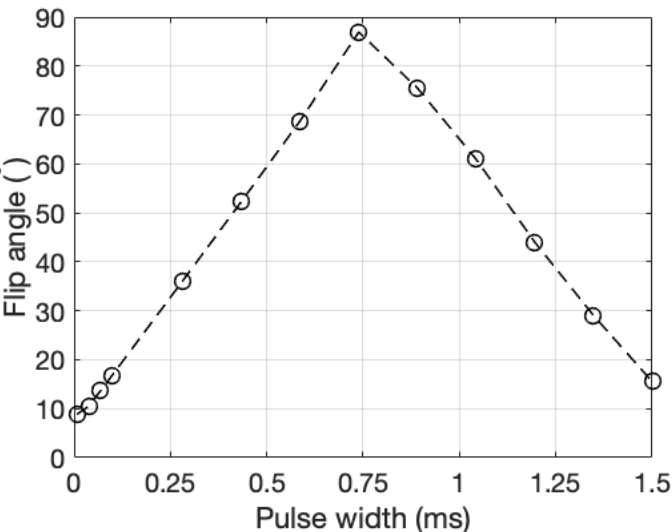
Figure A4. 129 Xe flip angle measurements for an amplitude of 2.4 V, at 32.8 kHz. Dashed lines are to guide the eye only.